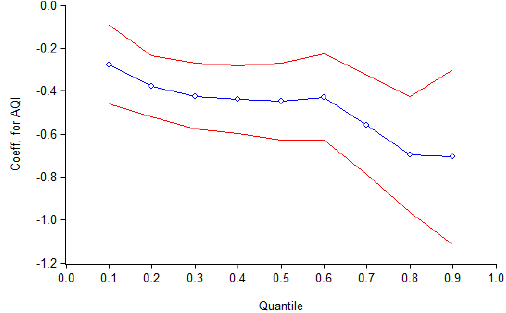
Figure 4. Quantile regression estimates with 95% confidence interval for the impact of haze on housing selling prices. Blue line indicates result from quantile regression. Red lines show 95% confidence interval for quantile regression.